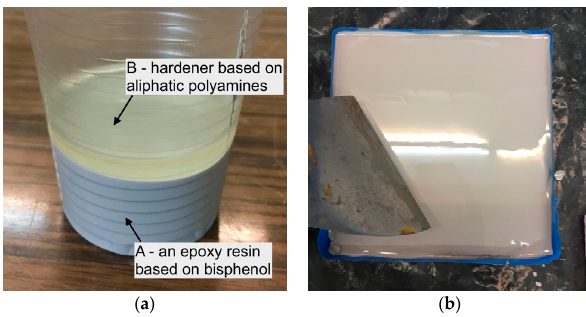
Figure 7. Epoxy resin coating: ( a ) Components–A & B; ( b ) sample after pouring fresh epoxy resin.